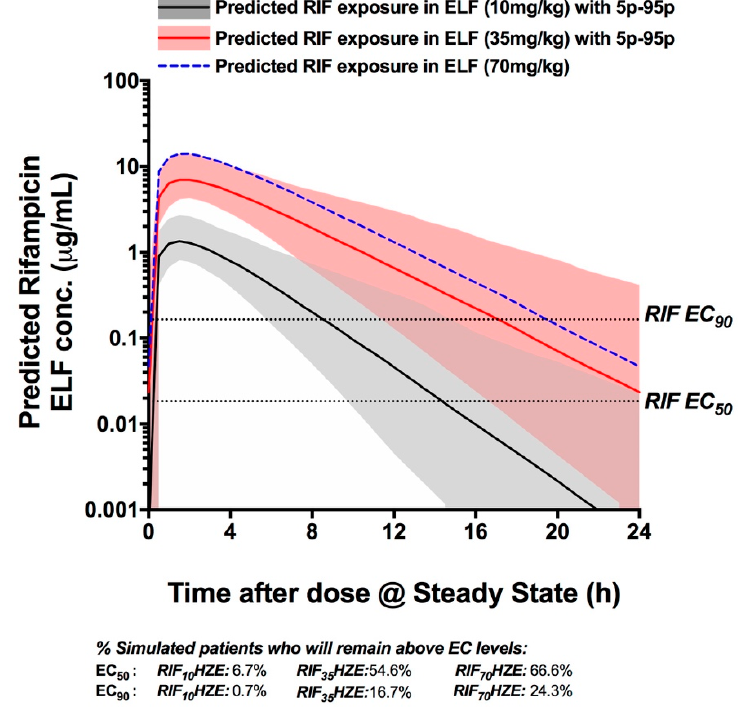
Figure 4. Monte Carlo PK simulations based on the parameters reported in Boeree et al. The simulations show the median exposures (lines) and 9–95 percentile range (shaded areas) for each treatment arm (Standard HRZE (R 10 HZE), solid black line and grey shading. Treatment containing 35 mg / kg RIF with HZE (RIF 35 HZE) is represented by a solid red line and orange shading; a hypothetical 70 mg / kg RIF with HZE that assumes similar PK parameters to RIF 35 (RIF 70 HZE) is represented by a dotted blue line; percentile range not shown for ease of overall comparison.